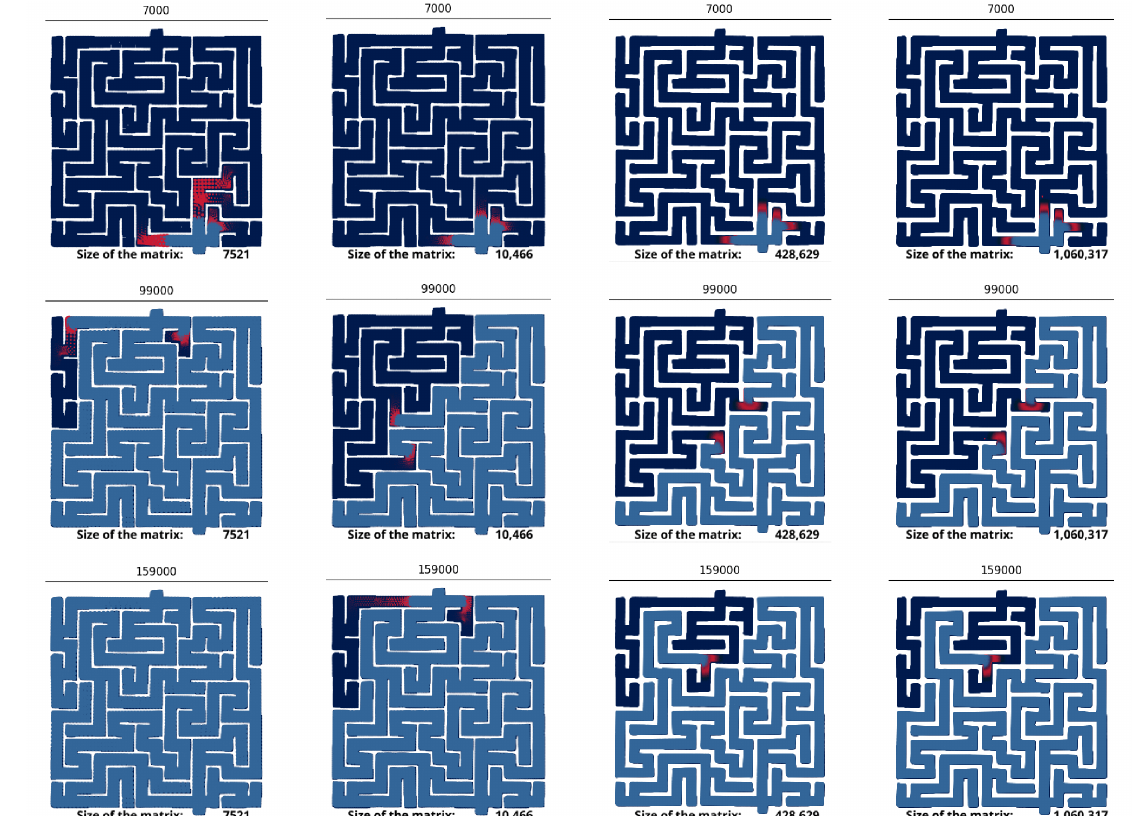
Figure 3. Numerical artifacts for coarse grained meshes. Snapshot of the simulations for coarse and fine meshes. The time-step is indicated at the top of each snapshot. The size of the mesh is indicated at the bottom of the snapshots. The prey is colored in red, and the predator colored in blue.